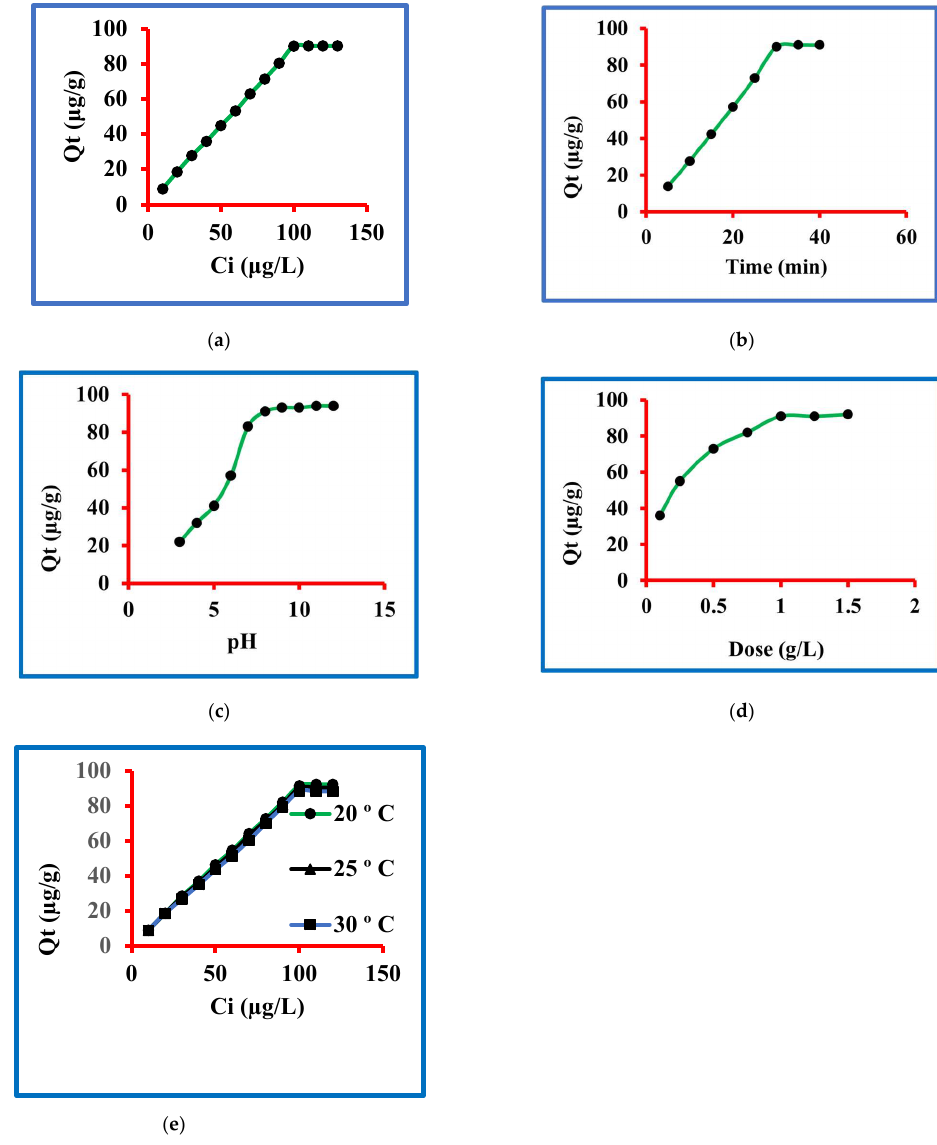
Figure 4. Sorption of triclosan ( a ) amounts, ( b ) time, ( c ) pH, ( d ) dose and ( e ) temperature.